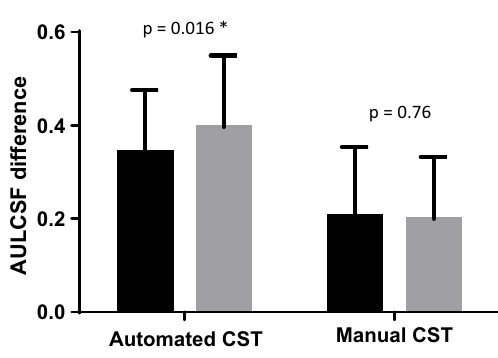
Figure 3. AULCSF difference of photopic and mesopic conditions in automated and manual CST devices according to decreased subjective night vision. AULCSF, area under log contrast sensitivity function; CST, contrast sensitivity test. *Statistically significant